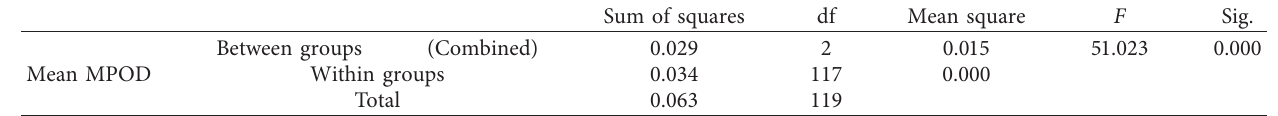
Table 9: ANOVA table shows the effect of moderate egg consumption ( ≥ 3 eggs/week) on mean MPOD. Sum of squares df Mean square F Sig. Mean